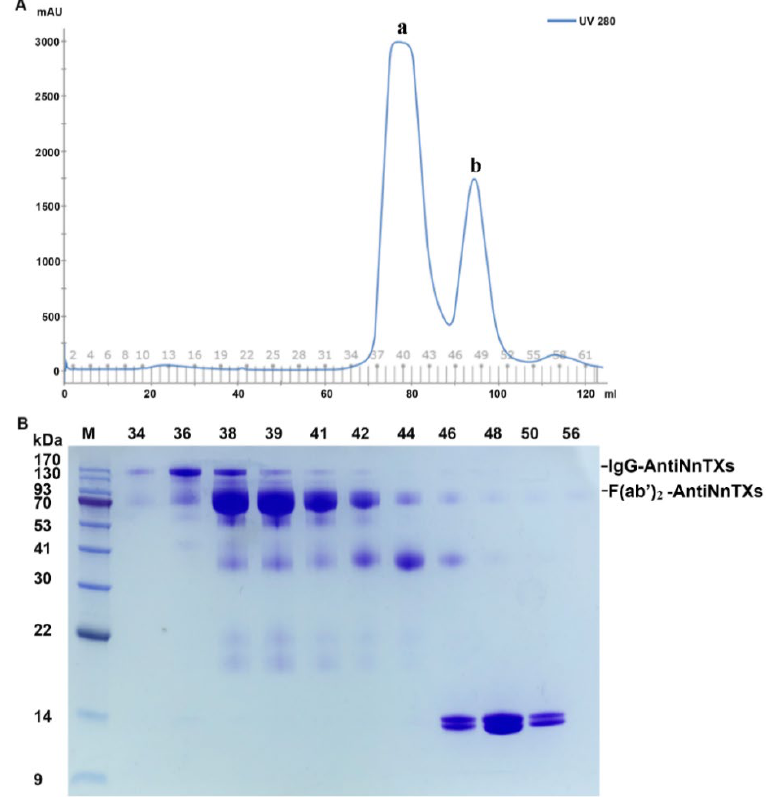
Figure 4. Purification of F(ab’) 2 -AntiNnTXs from the pepsin digests of IgG-AntiNnTXs. ( A ) Superdex 200 purification of F(ab’) 2 -AntiNnTXs from the pepsin digests of IgG-AntiNnTXs. ( B ) SDS-PAGE profile of the fractions from the size-exclusion chromatography purification. M: marker; 34, 36, 38, 39, 41, 42, 44, 46, 48, 50, 56: tube number of fractions.